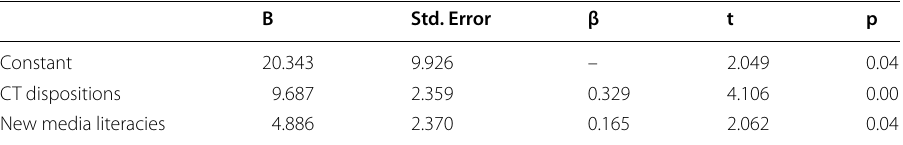
Table 3 Multiple linear regression results regarding the predictive role of CT dispositions and new media literacies on the ability to detect